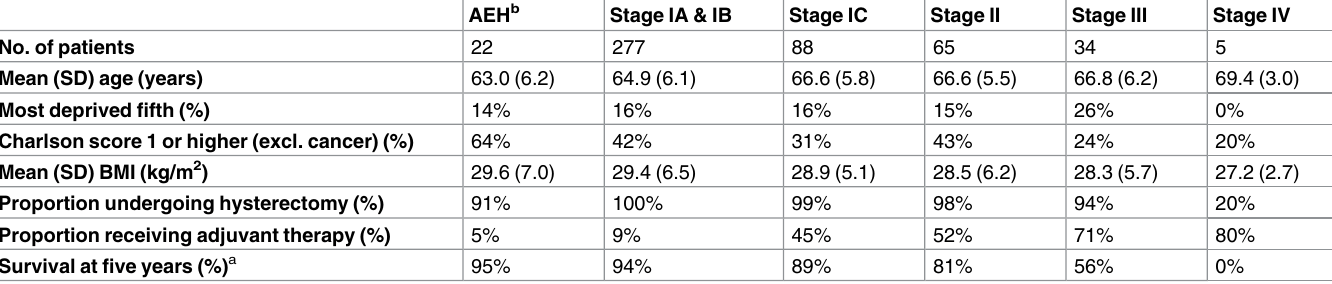
Table 1. Characteristics of patients in the study according to stage and five year survival.